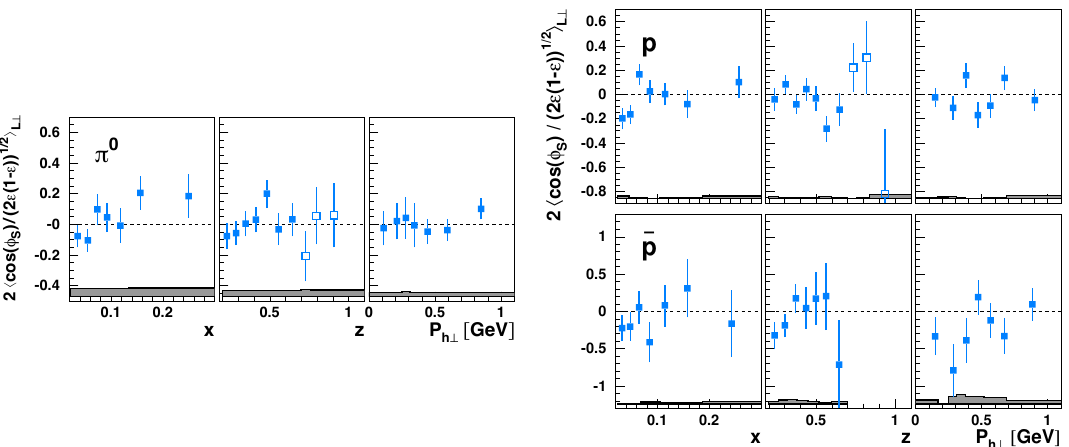
p Figure 32 . The 2 h cos( φ S ) / 2 (cid:15) (1 − (cid:15) ) i h amplitudes for π 0 (left), protons, and antiprotons (right) L ⊥ presented either in bins of x , z , or P h ⊥ . Data at large values of z , marked by open points in the z projection, are not included in the other projections (no such high- z points are available for an- tiprotons due to a lack of precision). Systematic uncertainties are given as bands, not including the additional scale uncertainty of 8.0% due to the precision of the target-polarization